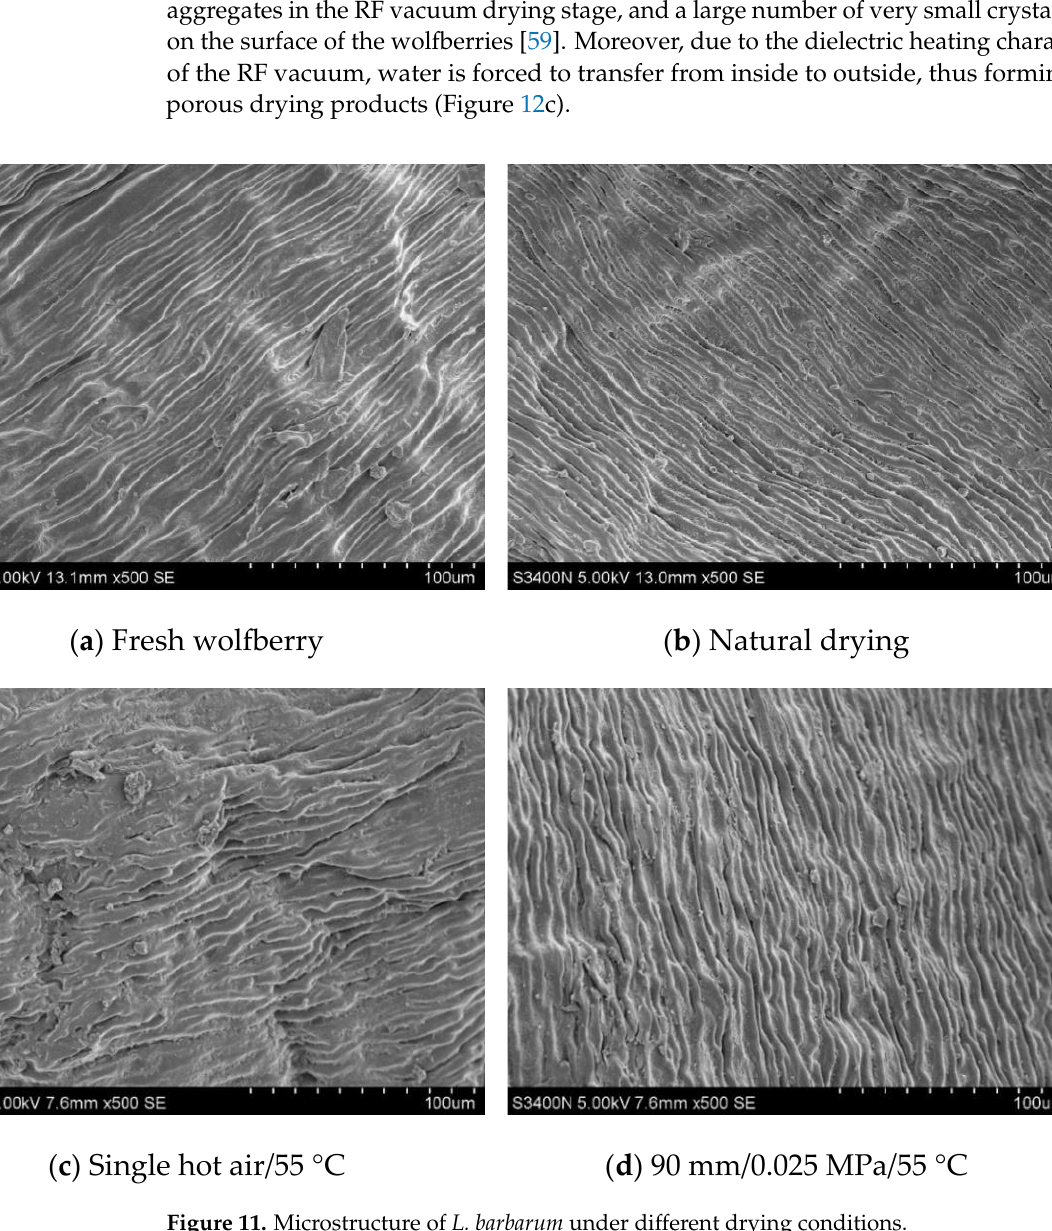
Figure 11. Microstructure of L. barbarum under different drying conditions.